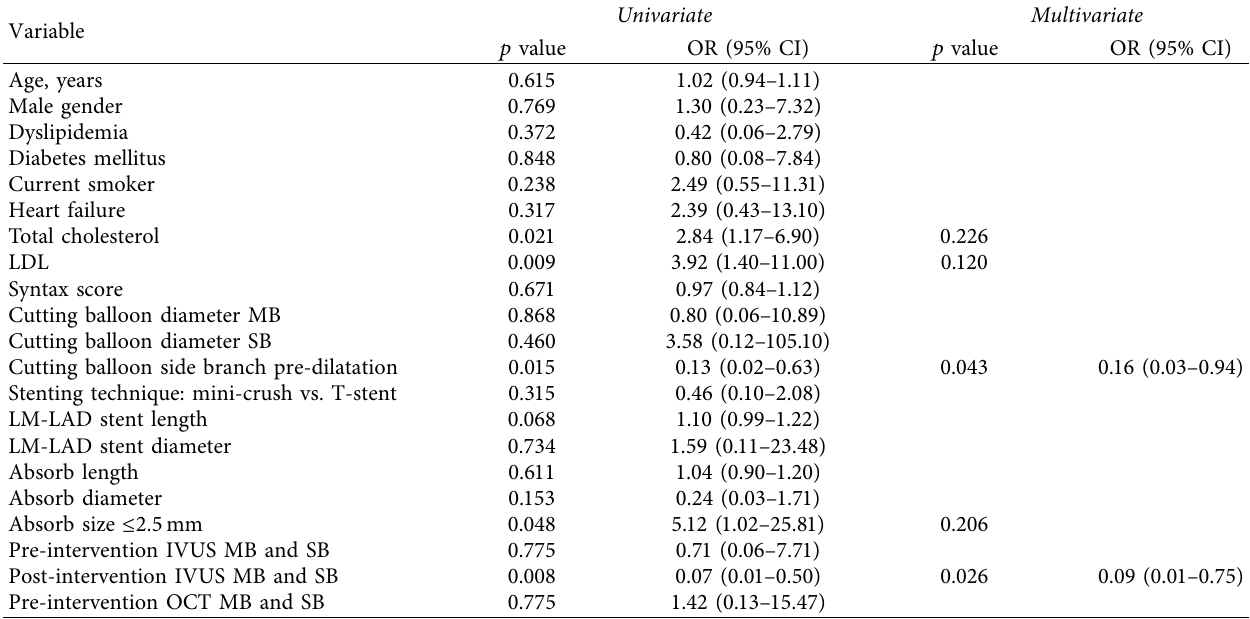
Table 5: Predictors of primary outcome measure by binary logistic